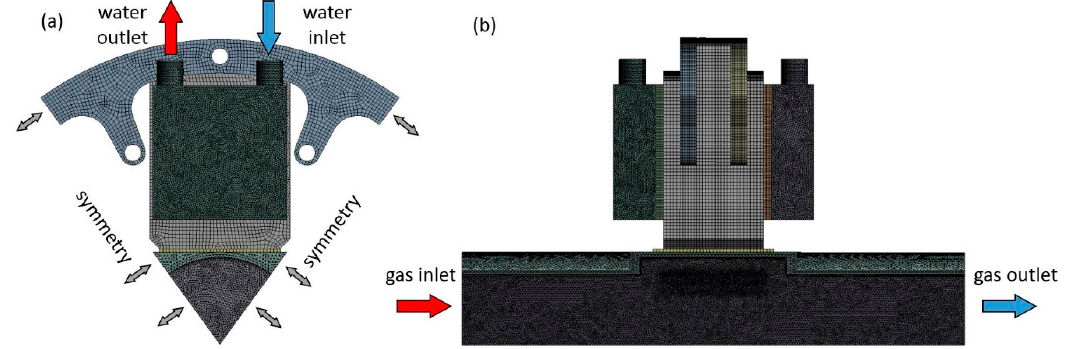
Figure 5 . Mesh and non-wall boundaries with a different color scheme than in Figure 4 for a better visualization. ( a ) Frontal view; ( b ) longitudinal view.